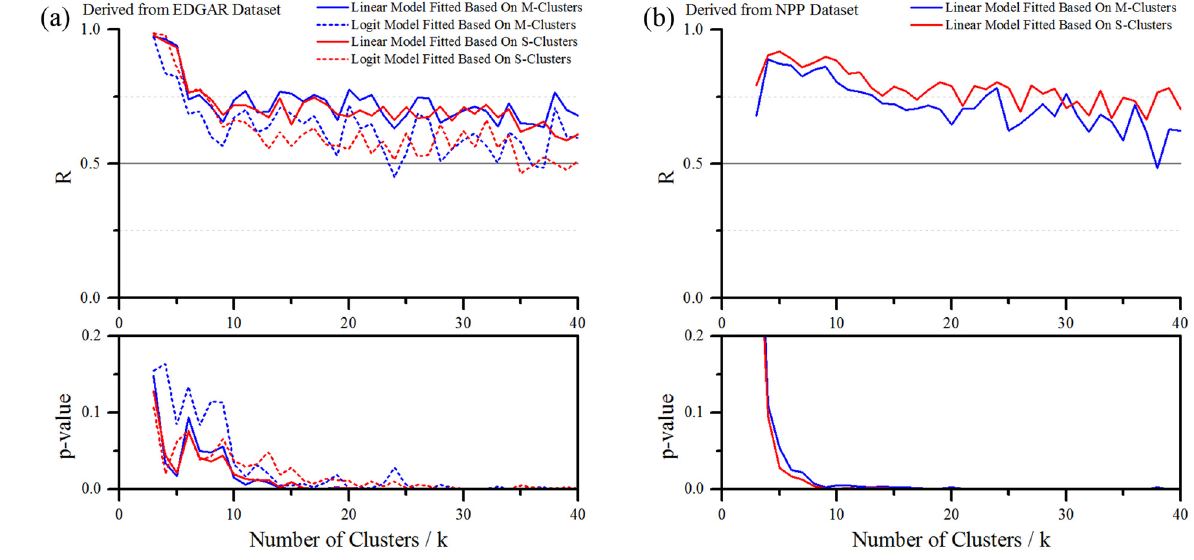
Figure 2. Correlation analysis: ( a ) R avg_e between the Xco on the clustering results; ( b ) R amp_n between the Xco clustering results.